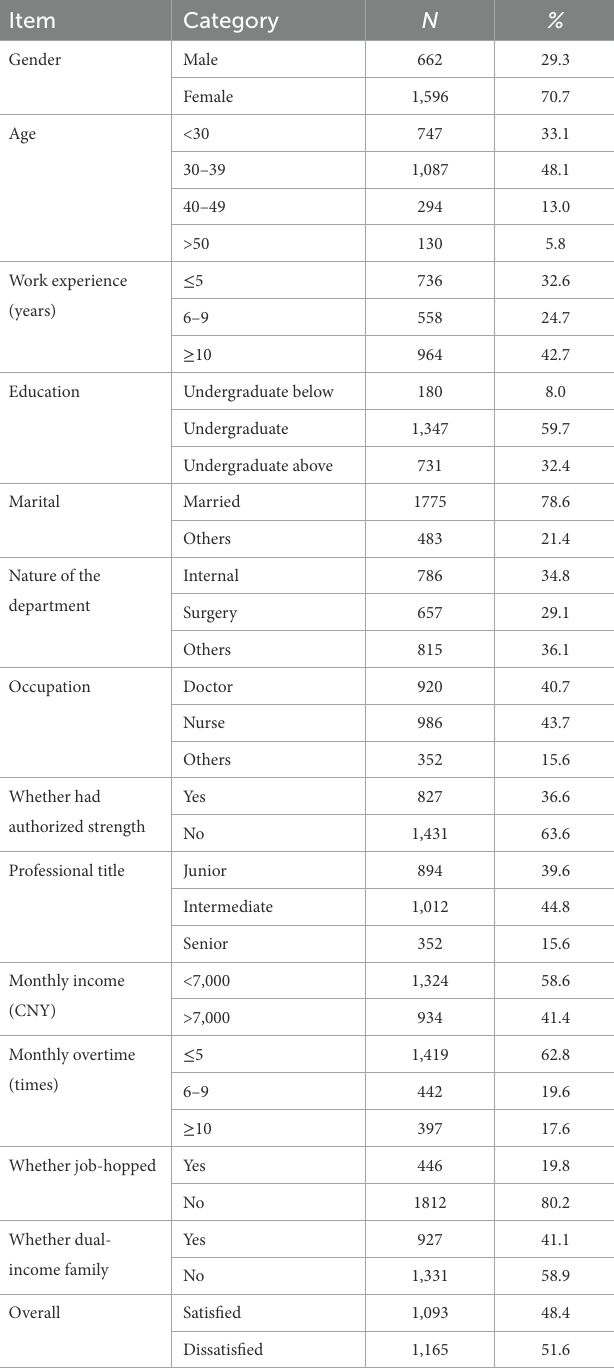
TABLE 1 Participants’ demographic characteristics ( N =